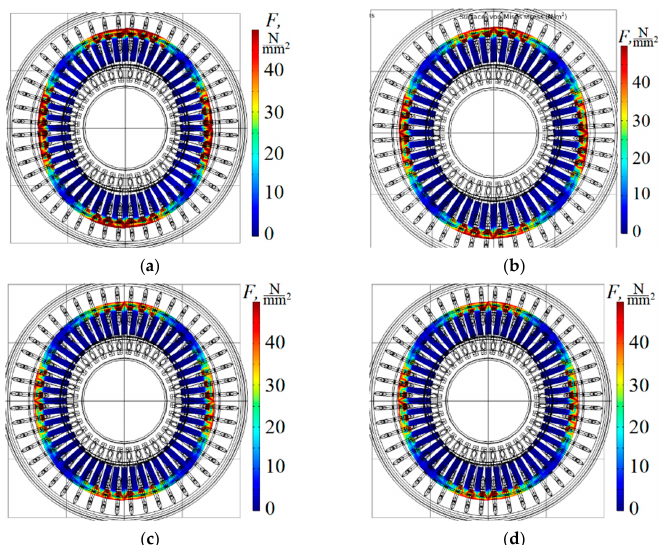
Figure 3. Von Mises stress in the stator core of the investigated motor with harmonic distortion of the supply voltage: ( a ) I g 3 = I g 5 = 0 A; ( b ) I g 3 = 8.8 A, I g 5 = 3.3 A; ( c ) I g 3 = 15.4 A, I g 5 = 7.7 A; ( d ) I g 3 = 15.4 A, I g 5 = 7.7 A, I A = 1.4· I B = 0.8· I C .